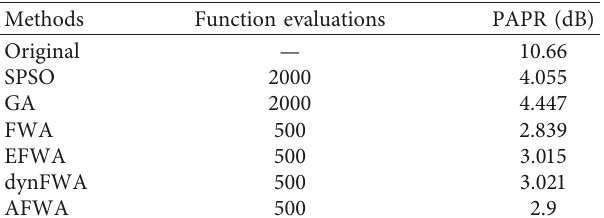
Table 3: Performance evaluation by the FWA, EFWA, dynFWA, AFWA, SPSO, and GA on one symbol OFDM over 10 independent